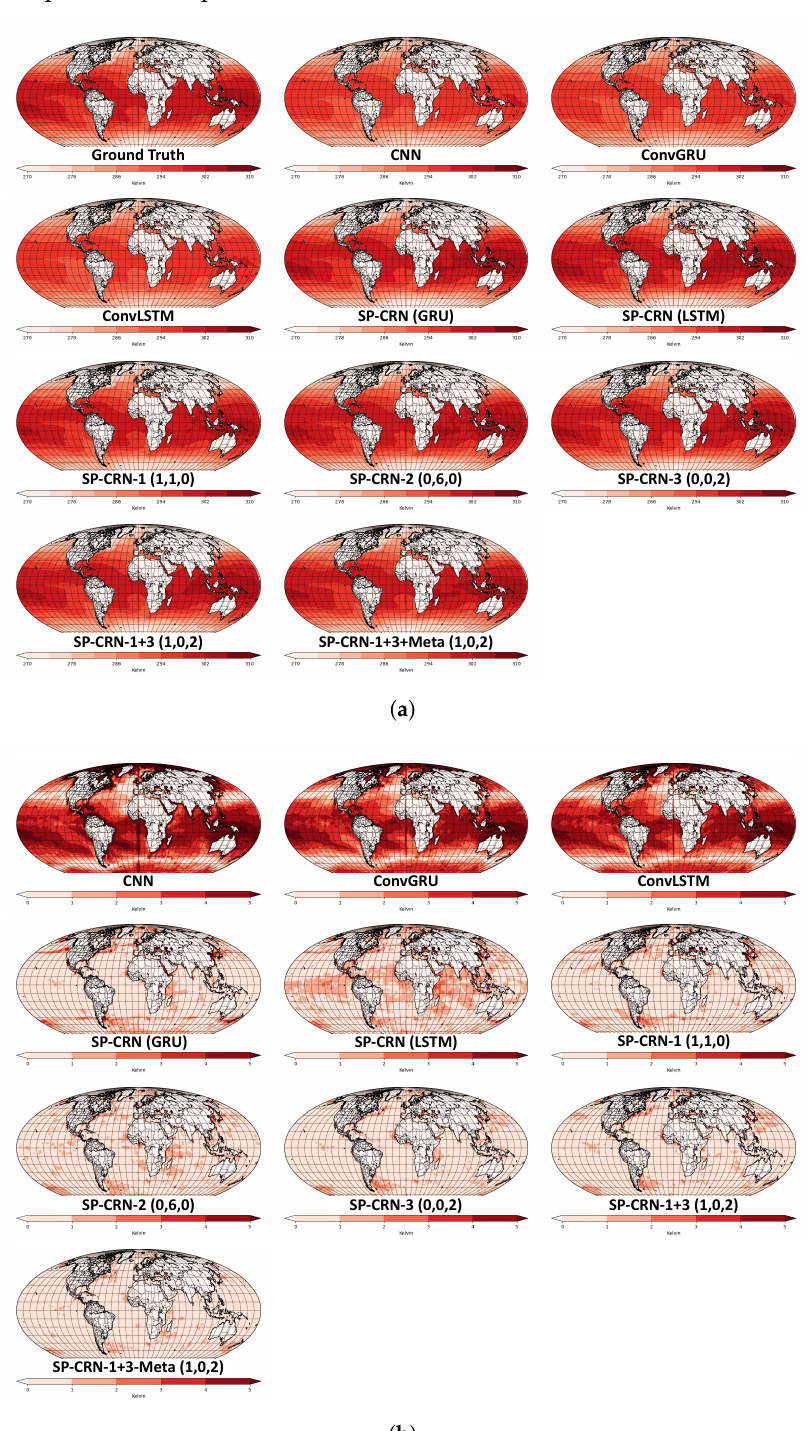
Figure 10. The prediction and error distribution of SST on January 2018. ( a ) Ground truth and prediction results. ( b ) Error distribution (absolute